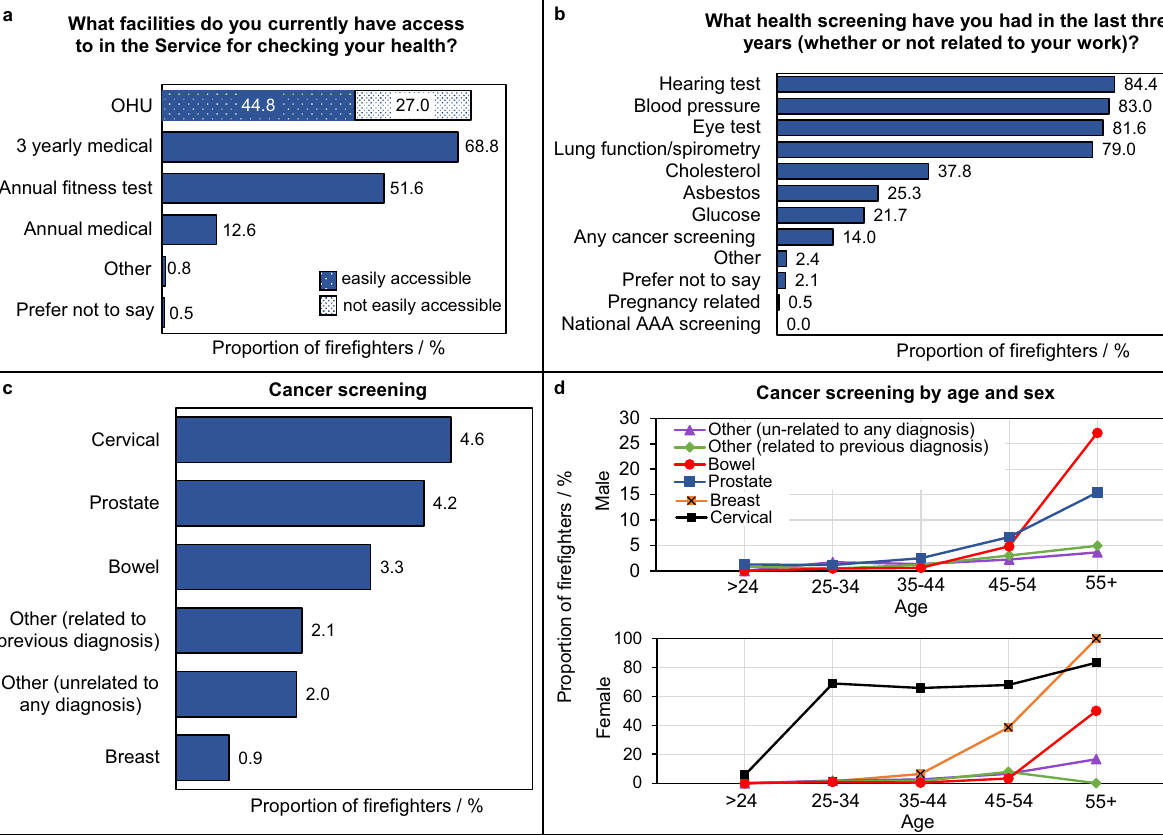
Figure 3. Health Screening in UK Fire and Rescue Services. The proportion of total surveyed firefighters who ( a ) have access to health screening facilities within their Service, ( b ) received specific health screening/tests over the last three years, and ( c ) received specific cancer screening over the last three years. Note firefighters can choose more than one type of screening and screening facility. ( d ) The proportion of male or female firefighters in each age bracket who received specific cancer screenings. AAA = Abdominal Aortic Aneurysm, OHU = Occupational Health